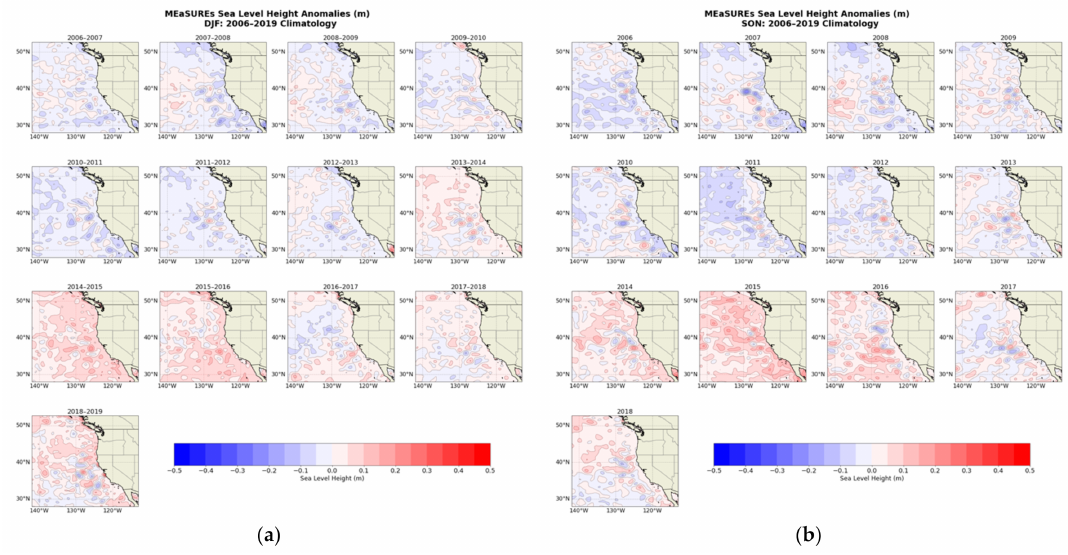
Figure 7. Making Earth System Data Records for Use in Research Environments (MEaSUREs) sea level height anomalies from 2006 through 2019, valid for ( a ) SON and ( b )